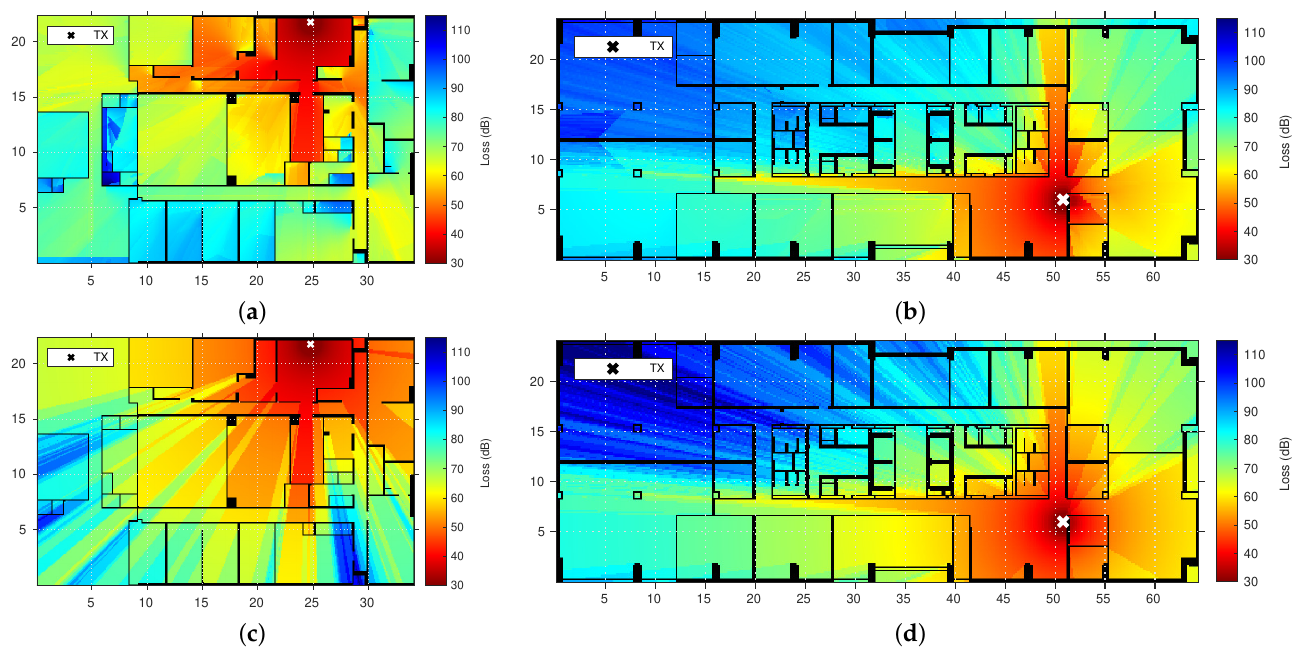
Figure 7. Predicted GPM PL is presented in ( a ) for the ship environment and in ( b ) for the office environment. For the purpose of comparison, the same is provided for the next best performing traditional model, AWM, in ( c ) for the ship environment and ( d ) for the office environment. We can see larger differences between GPM and AWM in the ship environment than in the office